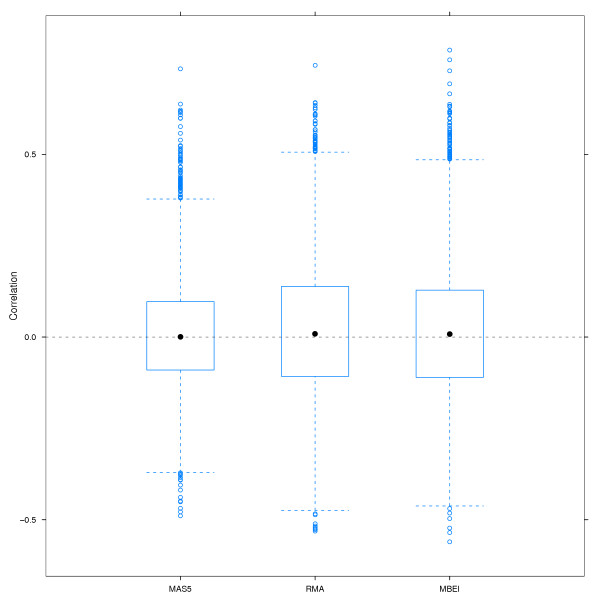
Correlations for 5000 random pairs of probe sets selected from KEGG pathways. Pairs were sampled from the subset of probe sets in the breast cancer data that appear in at least one KEGG pathway. Even for this smaller (n = 3137) and well-connected subset, the correlations are centered around zero.